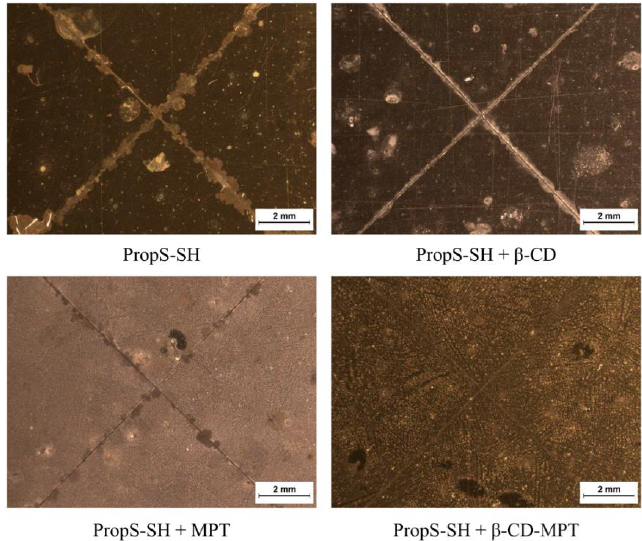
Figure 10. Surface aspect of cross-cut coupons at the end of a 4 week exposure to a cyclic acid rain (AR) spray test; only the PropS-SH coating containing the β -CD–MPT complex prevented the development of a corrosion attack starting from the scratches.